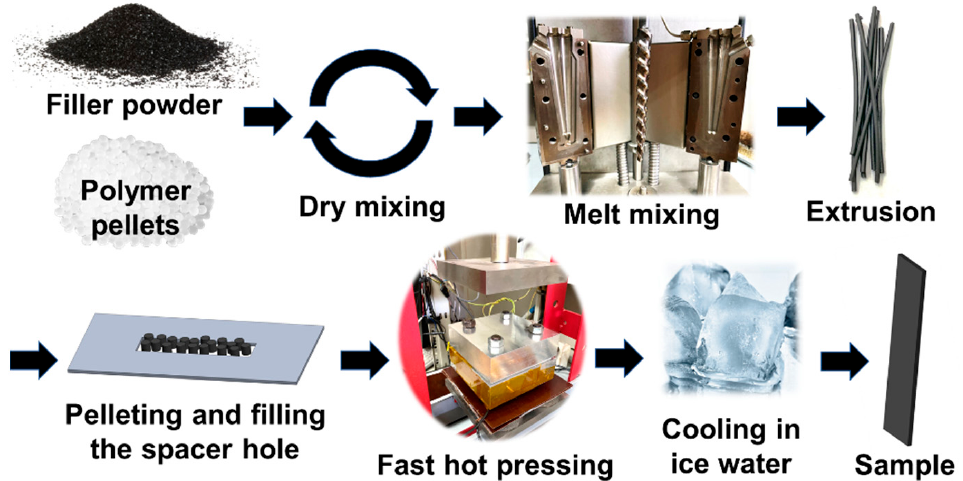
Figure 2. Scheme of manufacturing of solid composites samples for electrical conductivity meas- urements.